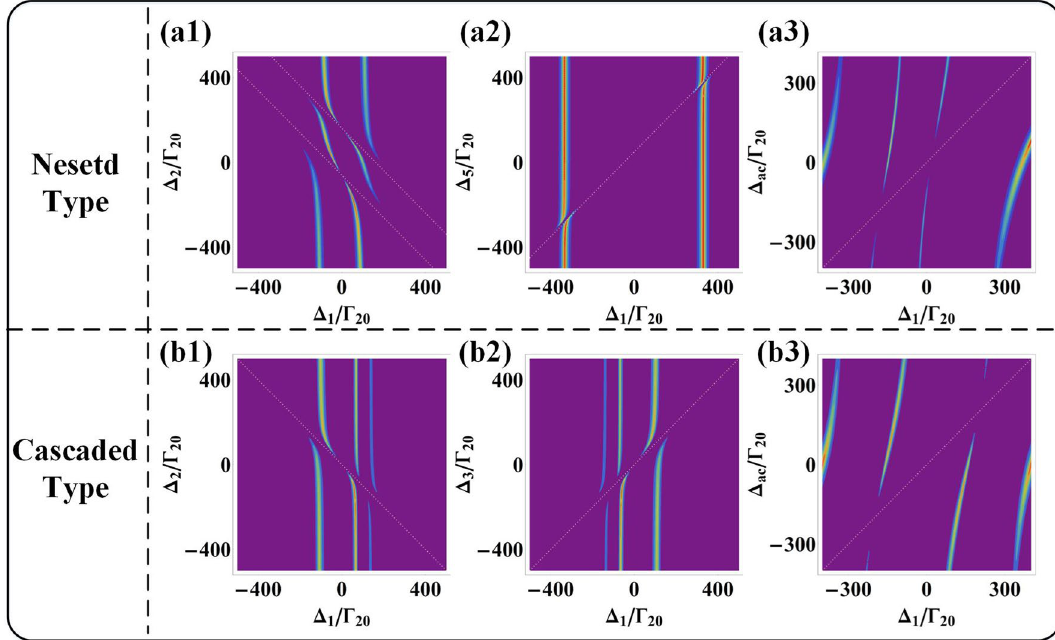
100 . ( a2 ) The interrelationship as Figure 3. ( a1 ) The interrelationship as function of (cid:31) 1 and (cid:31) 2 at � 5 /Ŵ 20 = 50 . ( a3 ) The interrelationship as function of (cid:31) 1 and (cid:31) ac at � 2 /Ŵ 20 80 function of (cid:31) 1 and (cid:31) 5 at � 2 /Ŵ 20 = = 0 . ( b1 ) The interrelationship as function of (cid:31) 1 and (cid:31) 2 at � 3 /Ŵ 20 100 . ( b2 ) The and � 5 /Ŵ 20 = = 100 . ( b3 ) The interrelationship as function of (cid:31) 1 and interrelationship as function of (cid:31) 1 and (cid:31) 3 at � 2 /Ŵ 20 = 200 and � 3 /Ŵ 20 200 (cid:31) ac at � 2 /Ŵ 20 = =